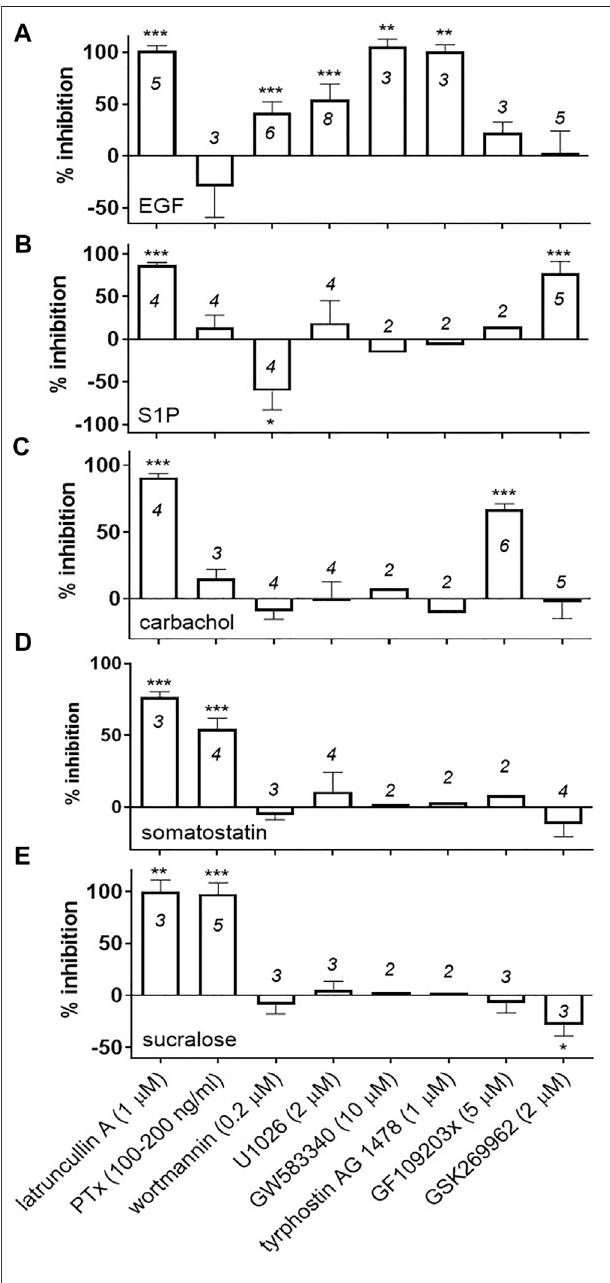
FIGURE 3 | Effect of pathway blockers on agonist-mediated DMR responses in R2/R3 U2OS cells. Cells were equilibrated at room temperature for 90 min in the Epic ® reader with the indicated concentrations of pathway blockers or latrunculin A. In the case of PTx, cells were incubated over night at 37 ° C and on the day of the experiment PTx was replaced with buffer and cells were equilibrated in the Epic ® reader as described above. A 5x- concentrated stock of agonist was then added onto the cells and DMR responses were recorded as described in Materials and Methods . Final